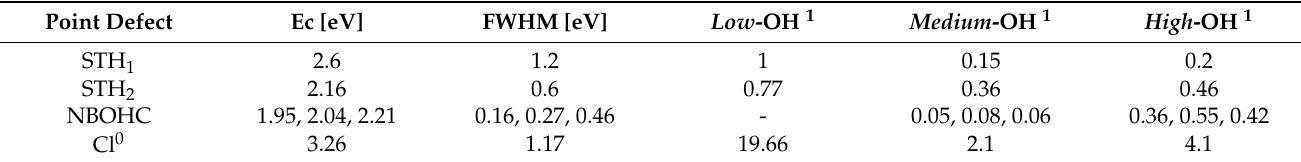
Figure 5. ( a ) Decomposition of the RIA spectrum measured for the low -OH sample at 300 kGy dose. Open circles represent the experimental data while the red line represents the best fitting function obtained by summing the different absorption bands related to single point defects. ( b ) Normalized RIA spectra, acquired at 300 kGy dose, with respect to the RIA measured at 2.8 eV (450 nm) for the low -, medium - and high -OH samples. Table 2. Best-fit parameters for the RIA at 300 kGy of the three tested